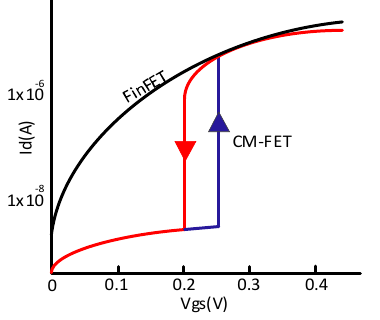
Figure 14. HFET &FinFET transition between ON and OFF states [51].